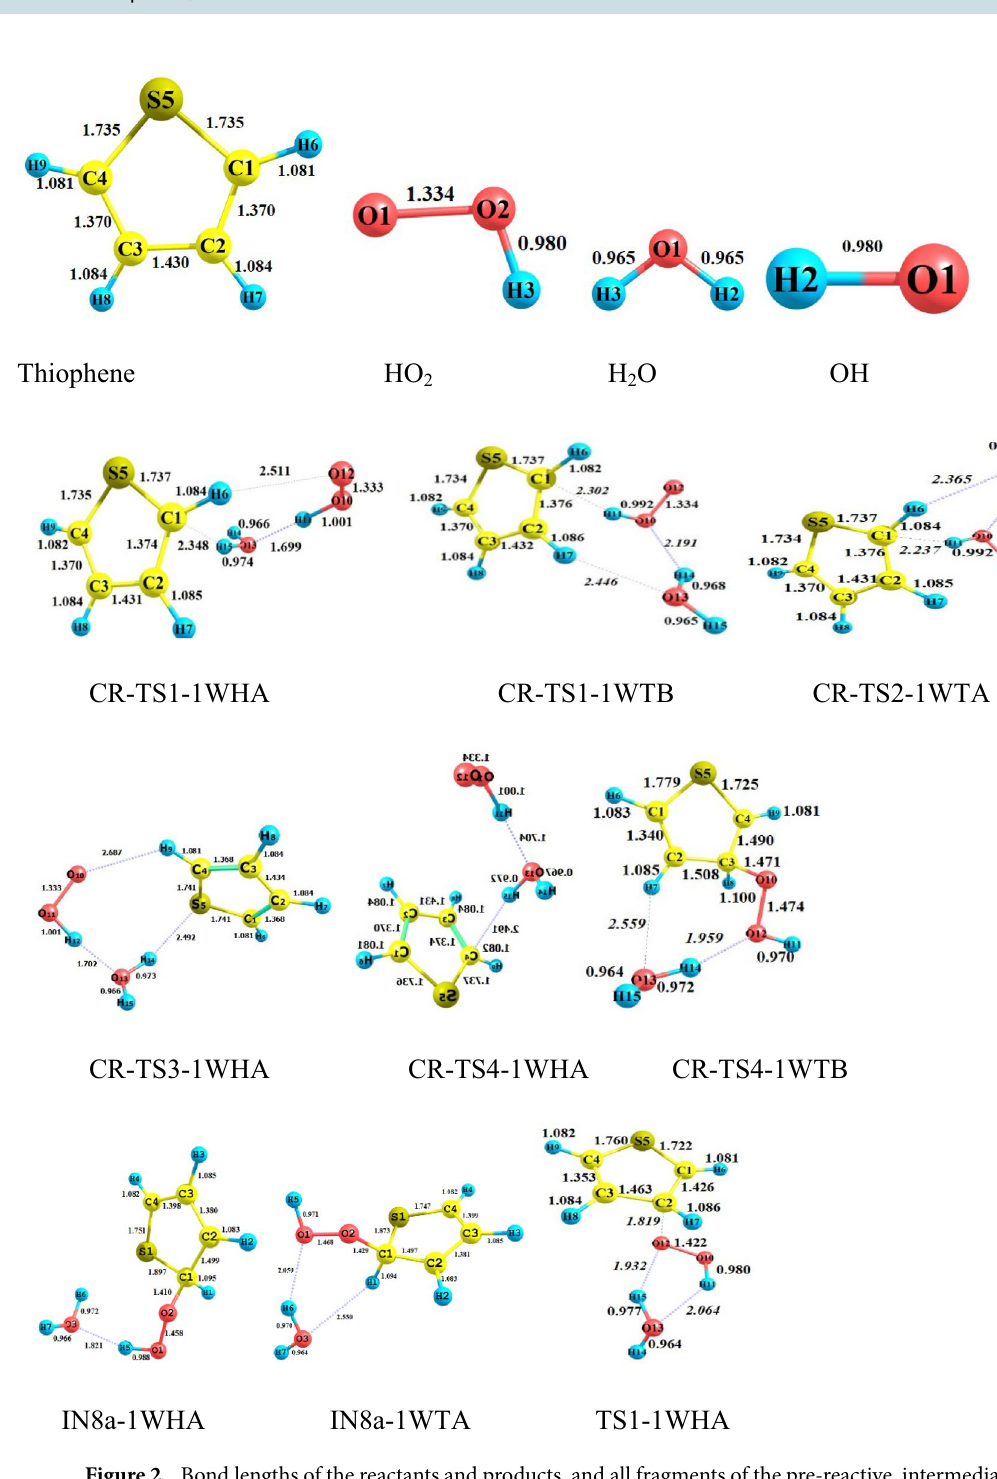
Figure 2. Bond lengths of the reactants and products, and all fragments of the pre-reactive, intermediates, transition states, and post-reactive complexes optimized at the B3LYP/6–31 + G(d,p) level (unit of all distances is